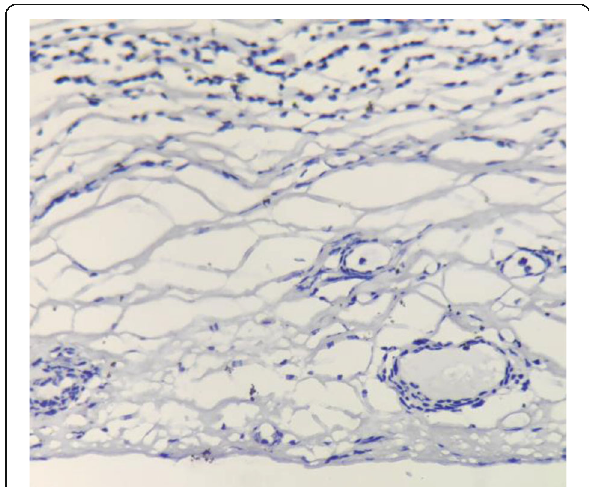
Fig. 10 Showing HP (magnification 400x) photomicrographs of CASE NO 1-Calretinin Negative (left). This was consistent with a diagnosis of